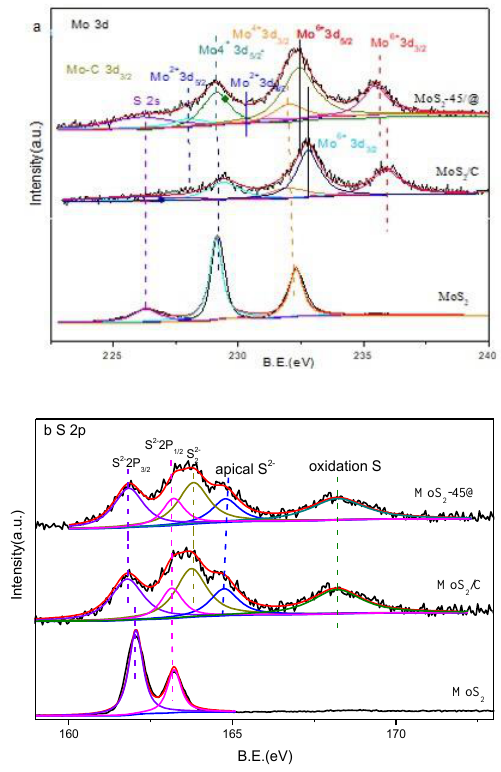
Figure 3. XPS of different catalyst: ( a ) Mo3d and ( b ) S2p.